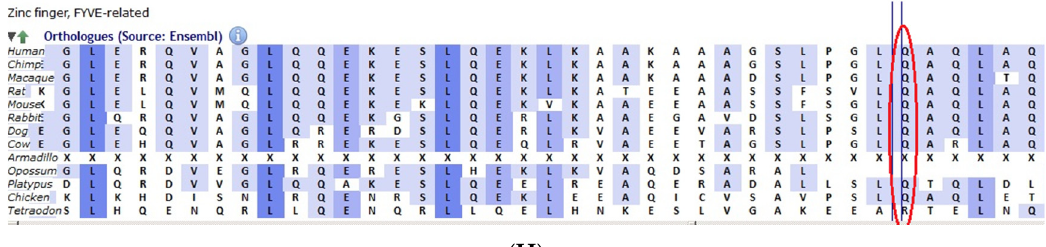
Figure 5. Pedigree of ACR12 ( A ). Eye picture of the proband (IV:1)—right eye ( B ) depicting posterior cortical cataracts and left eye ( C ) depicting Lamellar cataracts. Partial sequence chromatograms of the proband (( D ), IV:1) and control subject ( E ), FYCO1 exon 8, depicting a homozygous mutation (c.2935C > T; p.Gln979*). Mutant and wildtype nucleotide peaks “T” and “C” marked by an arrow. Mutational consequence leading to truncation (in red) compared with the wildtype sequence (in green) ( F ). RFLP analysis of the mutation p.Gln979* in FYCO1 ( G ), which shows co-segregation among the affected family members (IV:1 and IV:2). Unaffected parents are carriers (III:3 and III:4). Control (CTRL- DKC190) shows complete digestion. UD—undigested PCR product of the control sample. Amino acid sequence alignment of human FYCO1 and orthologs from other species ( H ) showing the conservation of p.Q979 (encircled in red).